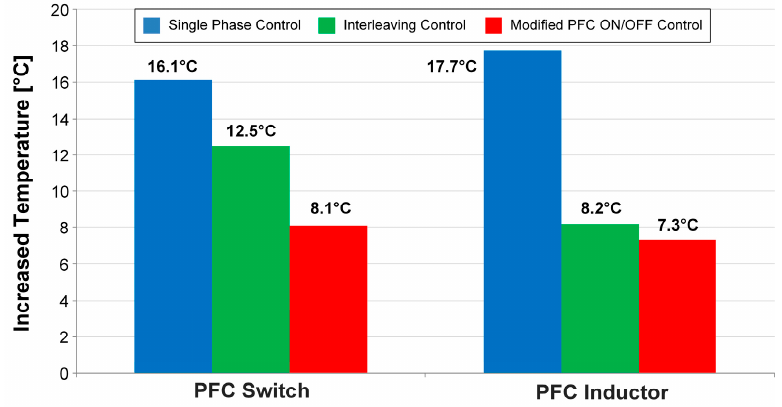
Figure 15. Increased temperature of PFC switch and inductor in three different control methods at 50% load condition. Initial temperature is 26 °C and 29 °C for switch and inductor, respectively.